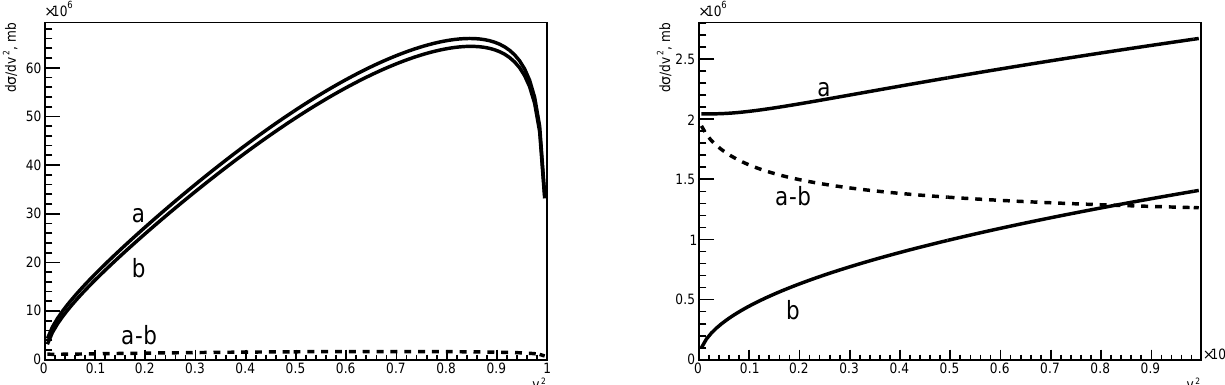
Figure 2. The distribution of masses of dielectrons produced in ultraperipheral collisions at NICA energy with ( a ) and without ( b ) account of the SGS-factor. Their difference (a-b) is shown by the dashed line. The region of small masses is shown in the right-hand side at the enlarged scale. Note the factor 10 − 6 at the abscissa scale which reduces it to MeVs.